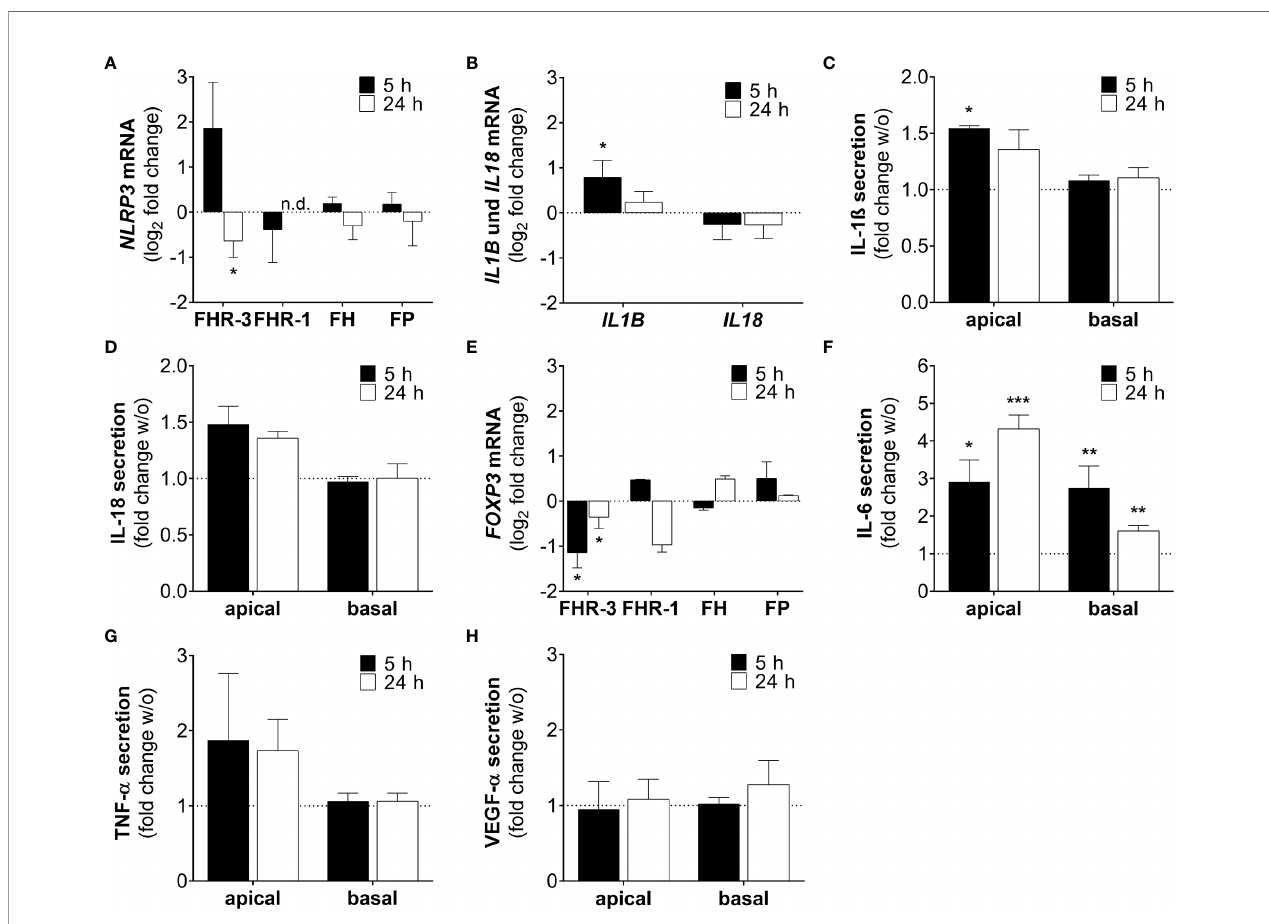
FIGURE 8 | FHR-3 induced an ARPE-19 cell dependent pro-in fl ammatory microenvironment. (A) NLRP3 mRNA expression in ARPE-19 cells was either increased or decreased after 5 h or 24 h FHR-3 treatment, respectively. This was in contrast to no expression changes following FHR-1, FH or FP incubation. (B) Transcripts of IL1B were signi fi cantly elevated, whereas IL18 mRNA expression was slightly decreased after FHR-3 treatment. (C, D) Apical secretion levels of (C) IL-1ß and (D) IL-18 were increased in ARPE-19 cells after FHR-3 stress. (E) FOXP3 mRNA expression was reduced 5 h and 24 h after FHR-3 incubation. (F) Secretion of IL-6 protein was signi fi cantly raised after FHR-3 incubation, both on the apical and basal cell site. (G) ARPE-19 cell secretion of TNF- a protein was on trend increased after FHR-3 incubation on the apical site compared to w/o. (H) VEGF- a was secreted by ARPE-19 cells, but showed no differences between FHR-3 treated and untreated cells. w/o untreated control (dotted line). n.d. not detected. Mean with standard deviation is shown. ***p < 0.001, **p < 0.01, *p < 0.05. (A, B, E) Wilcoxon matched-pairs signed rank test (n = 3); (C, D, F – H) Unpaired t-test (n =